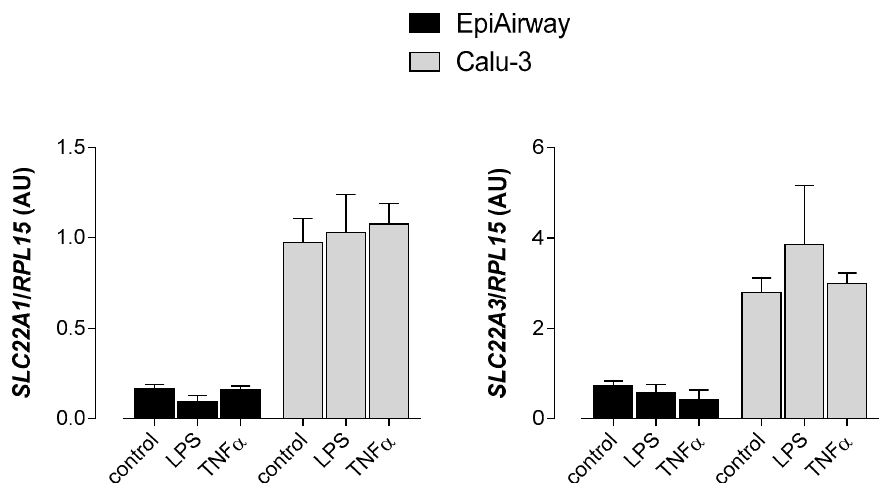
Figure 5. E ff ect of inflammatory stimuli on the expression of SLC22A1 and SLC22A3 in EpiAirway ™ and Calu-3. LPS (10 µ g / mL) and TNF α (10 ng / mL) were added to the culture medium for 24 h. The expression of SLC22A1 / OCT1 and SLC22A3 / OCT3 was determined with qRT-PCR and shown after normalization for the expression of the reference gene ( RPL15 ). Data are means ± SEM of three independent determinations.